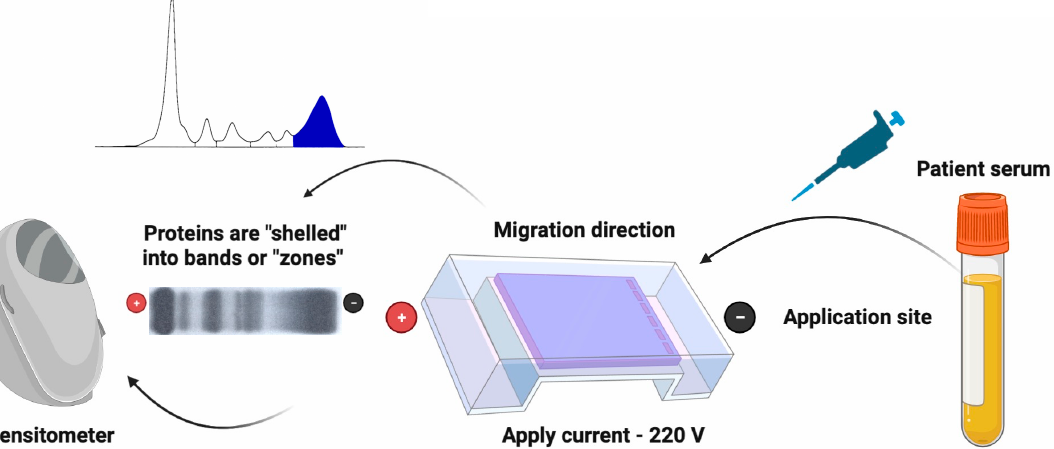
Figure 1. Serum protein electrophoresis (ELF) shows a marked polyclonal hypergammaglobulinemia. The most classic electrophoretic application is the “zonal” one: an aliquot of serum is applied near the cathode ( − ) on a solid support immersed in an alkaline buffer; the proteins are “shelled” into bands or “zones” (albumin, a1, a2, b and g globulins) which are formed due to their different speed of migration towards the anode (+). The solid support generally consists of cellulose acetate, agarose gel or polyacrylamide gel. After the electrophoretic run, the support is suitably fixed, colored, and read in densitometry for the definition of the traces and the evaluation of the percentages.